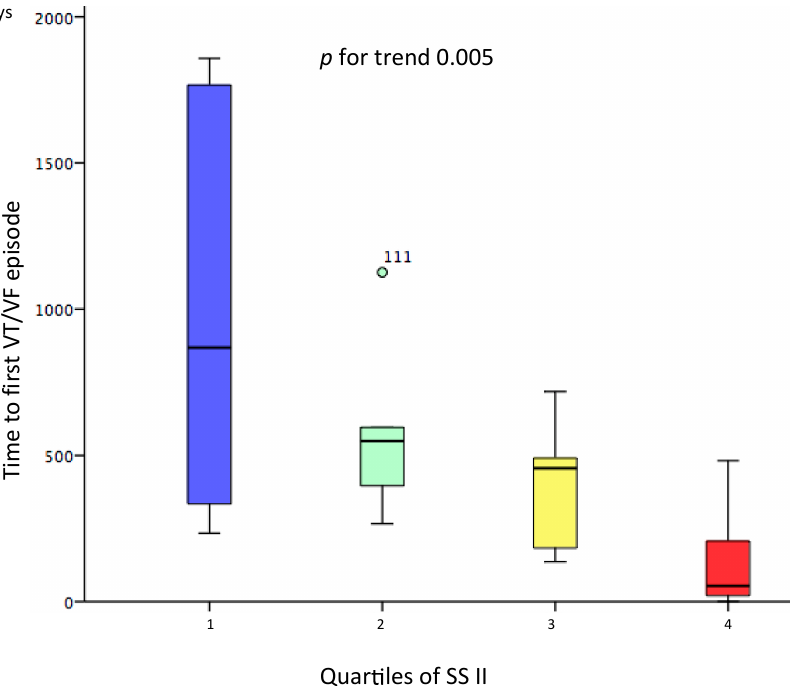
Figure 3. Whisker plots showing the time to recurrence of the VT/VF episode in the different quartiles of the SS II. The symbols ◦ represents an outlier.